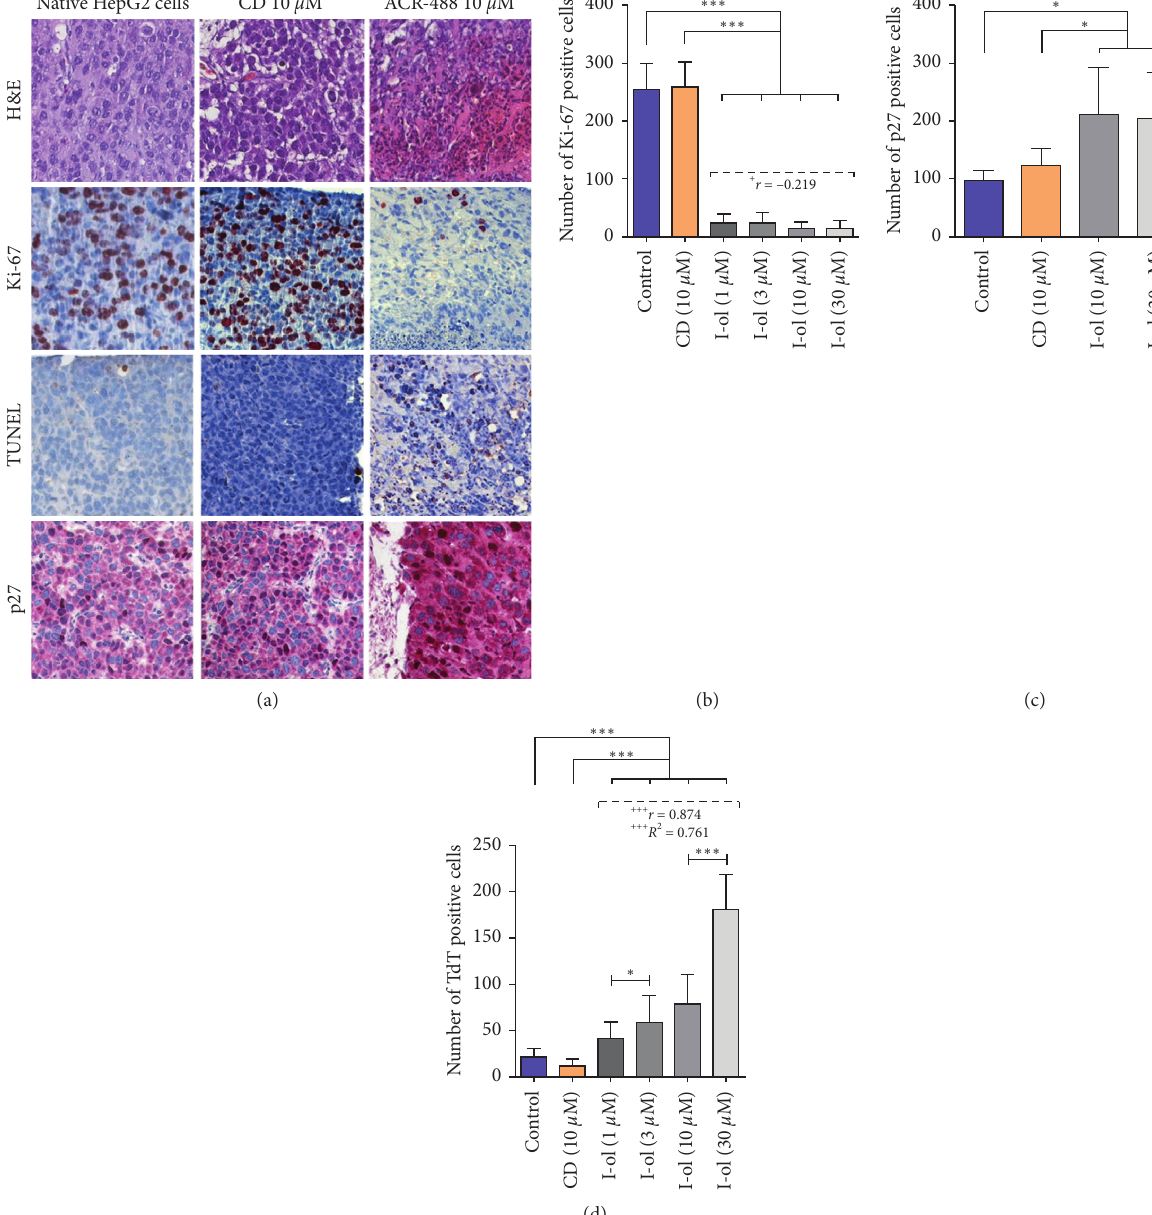
Figure 5: HepG2 cell growth in CAM tissues. (a) Representative images of H&E staining, Ki-67 and p27 immunohistochemistry, and TUNEL assay results. The magnification of the objective lens was 20-fold, and that of the ocular lens was 10-fold, such that the total magnification was 200-fold. (b) A massive reduction in the number of Ki-67-positive cells was observed after incubation with I-ol at the lowest concentration. (c) Induction of p27 protein expression. (d) Linear increase of apoptotic cells, compared with the control groups. The results are shown as the mean ± SD. Statistical calculations were performed based on two-way mixed ANOVA, followed by Bonferroni’s post hoc test. In all cases, the significance level was ∗ p < 0 . 05 (significant), ∗∗ p < 0 . 01 (highly significant), or ∗∗ p < 0 . 001 (very highly significant). Dose-dependent effects of I-ol were calculated by determining Pearson’s correlation coefficient ( r ) and performing linear-regression analysis (adjusted R 2 ), with the following statistical parameters: + p < 0 . 05 (significant), ++ p < 0 . 01 (highly significant), and +++ p < 0 . 001 (very highly